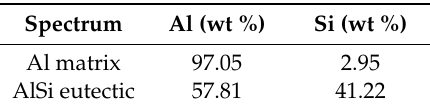
Table 1. EDX point analysis